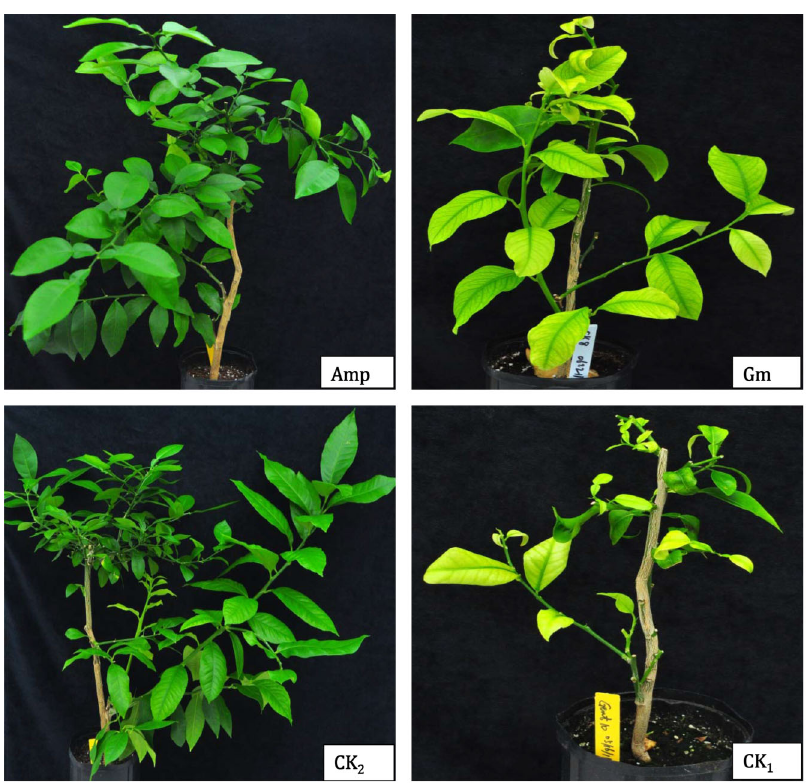
Figure 2. Huanglongbing symptoms of the inoculated plants. Healthy grapefruit rootstocks graft-inoculated with HLB-affected lemon scions treated with ampicillin at a concentration of 1.0 g/L ( Amp ), gentamicin at a concentration of 100 mg/L ( Gm ), and a water control (disease control, CK 1 ); The healthy plants were graft-inoculated with Las-free lemon scions (healthy control, CK 2 ).